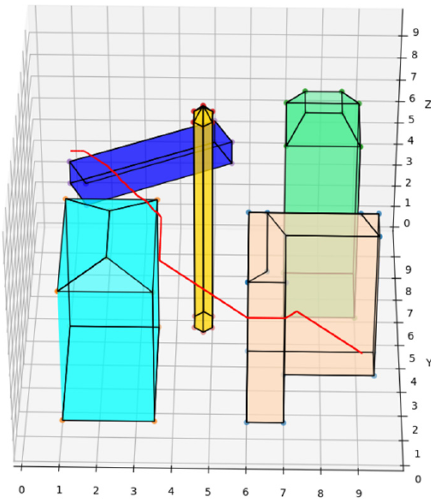
Figure 8. UAV route deploying traditional A* route planning algorithms in disturbance-free scenarios.